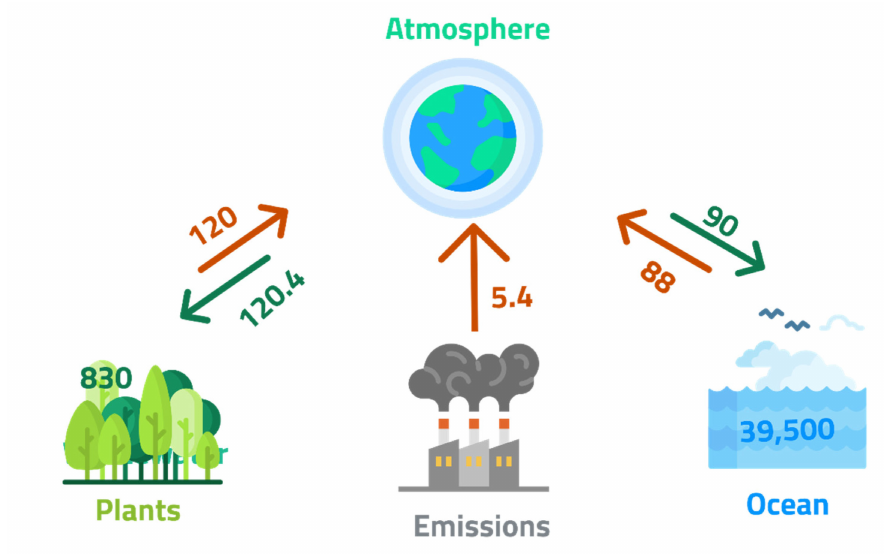
Figure 13. Global carbon reservoirs (GtC) and their net fluxes (GtC per year), adapted from Sanna et al.